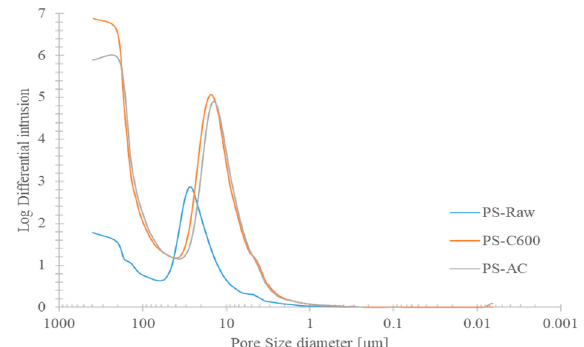
Figure 10. Pore size (mL · g − 1 ) logarithmic distribution evaluated through mercury porosimetry for PS-Raw, PS-C600 and PS-AC, according to the criteria of Soil Science Society of America (SSSA). For PS-Raw, the largest amount of pores occurred for ranges from 52 μ m to 10 μ m, while for PS-C600 and PS-AC the corresponding largest amounts ranged between 392 and